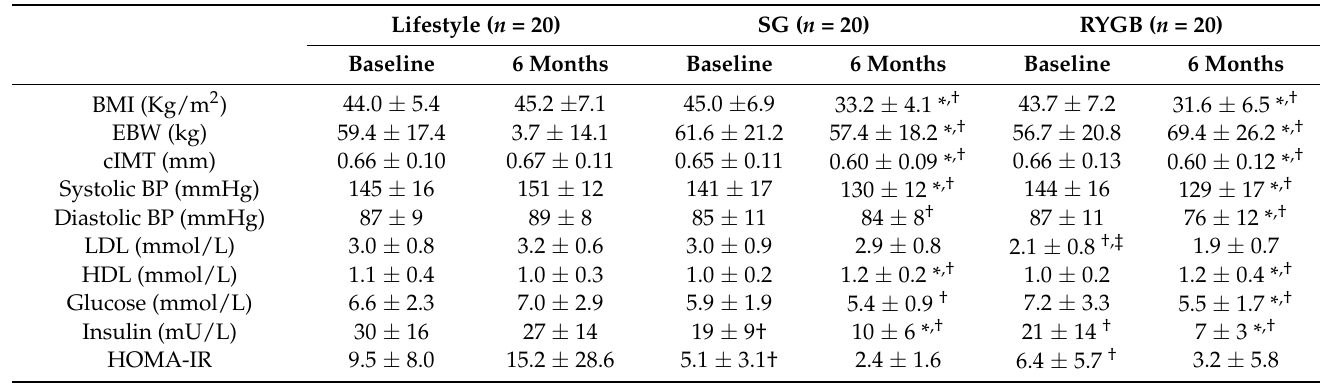
Table 4. Baseline and follow-up characteristics regarding the type of therapy for obesity.